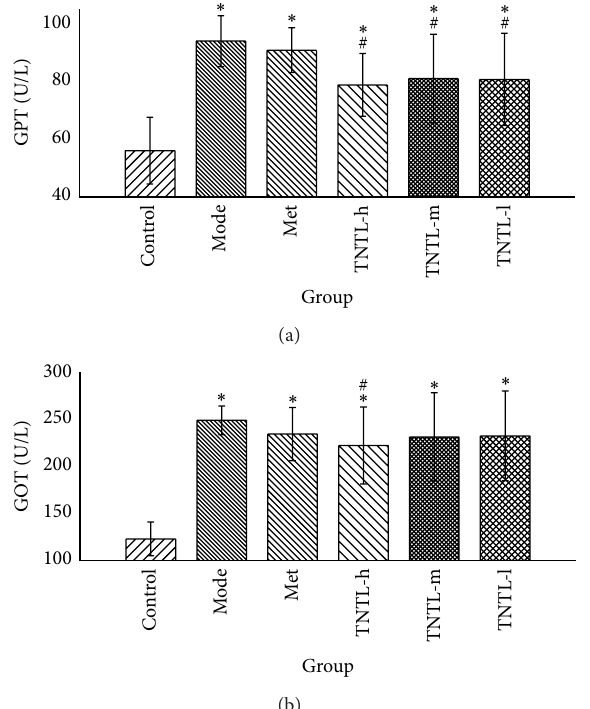
Figure 8: Renal function in db/db mice. The TNTL (TNTL-h, m, l = 3.6 g, 1.8 and 0.9 g/kg b.w., resp.) administration resulted in reduced plasmalevelsofBUN(a)andCRE(b),comparedtothemodelgroup. The TNTL groups (3.6 g/kg) have significant reductions in levels of BUN (a) and CRE (b), compared to Met group. The TNTL groups (3.6 g/kg) have significant reductions in levels of BUN and CRE by 18% and 10%, respectively, compared to the model group. Control: C57BL, DM: db/db mice with untreated, Met: db/db mice treated with metformin, and TNTL-h, m, l: db/db mice treated with 3.6 g, 1.8 and 0.9 g/kg b.w., respectively. # 𝑃 < 0.05 compared with DM group. ∗ 𝑃 < 0.05 compared with control